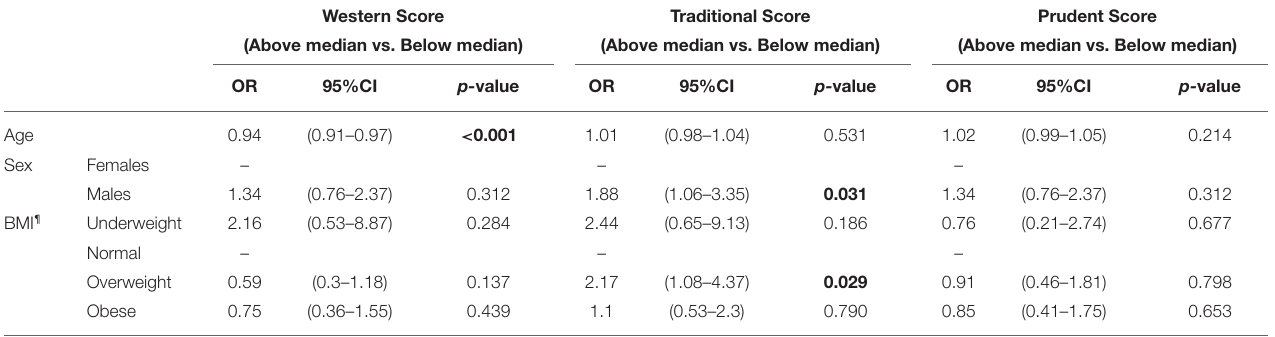
TABLE 5 | Multiple logistic regression for the associations between the various genotypes and their alleles with the identified dietary patterns in the study population ( n = 194)*. Gene and risk